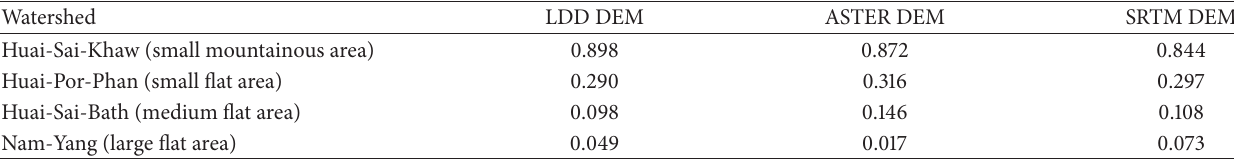
Table 12: Slopes of main streams extracted from LDD DEM, ASTER DEM, and SRTM DEM. Watershed